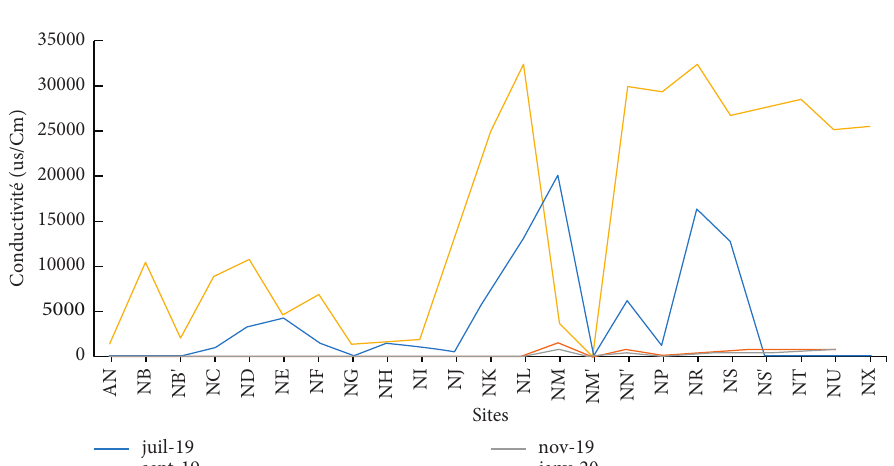
Figure 3: Temporal variation of the pH in the water.